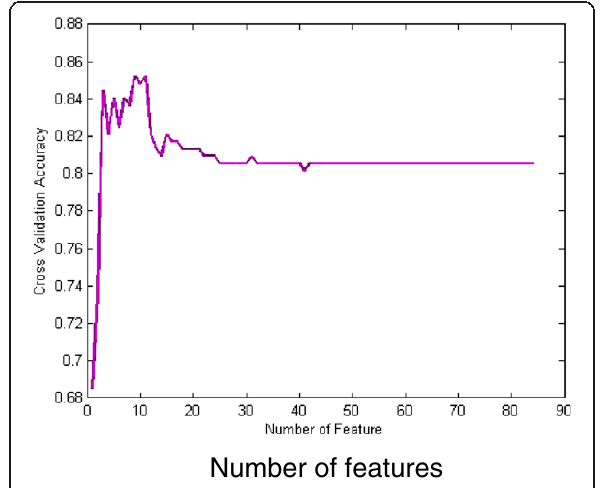
Figure 5 The trend of the cross validation accuracy versus retained feature number by